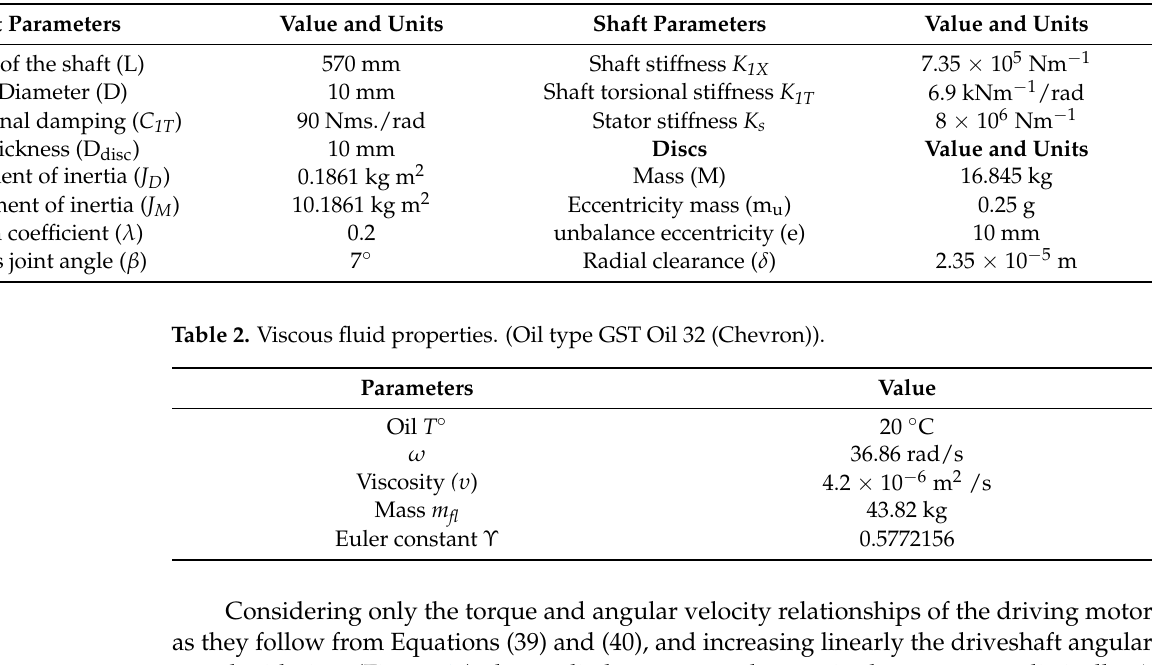
Table 1. Rotor system R-K 4 parameters.